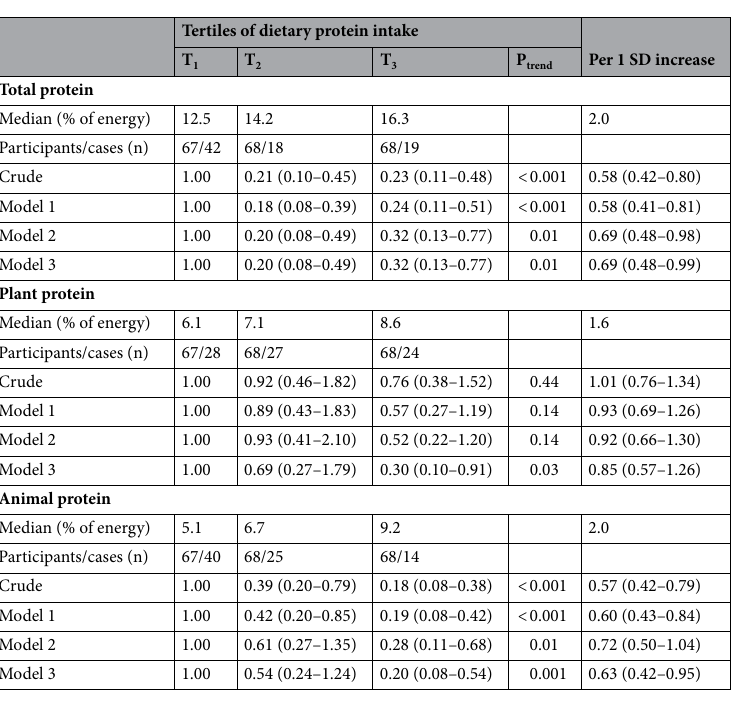
Table 3. Multivariable-adjusted odds ratio for MUO (based on IDF criteria) across tertiles of dietary total, plant, and animal protein intake (n = 203) 1 . 1 All values are odds ratios and 95% confidence intervals. Model 1: Adjusted for age, gender, energy intake. Model 2: More adjustments for physical activity levels, socioeconomic status. Model 3: Further adjustments for total dietary fat intake, plant protein (for animal protein), animal protein (for plant protein) and